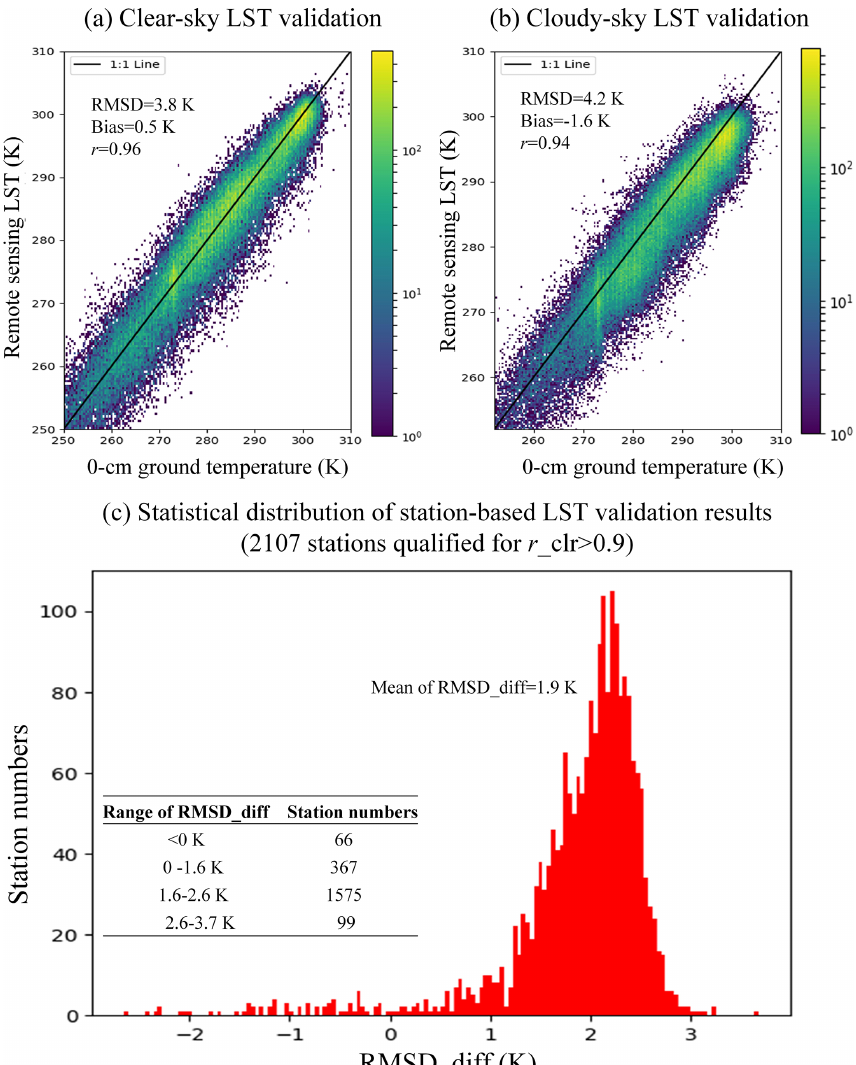
Figure 3. Validation results of the cloud gap-filled LST in China. (a) Density plot of thermal-infrared LST under clear-sky conditions com- pared to the 0cm ground temperature measurements for all stations. (b) Same as (a) but for thermal-infrared LST under cloudy conditions. (c) Statistical distribution of difference between RMSD of clear-sky LST and RMSD of gap-filled LST under cloudy conditions with regard to different meteorological stations over the study